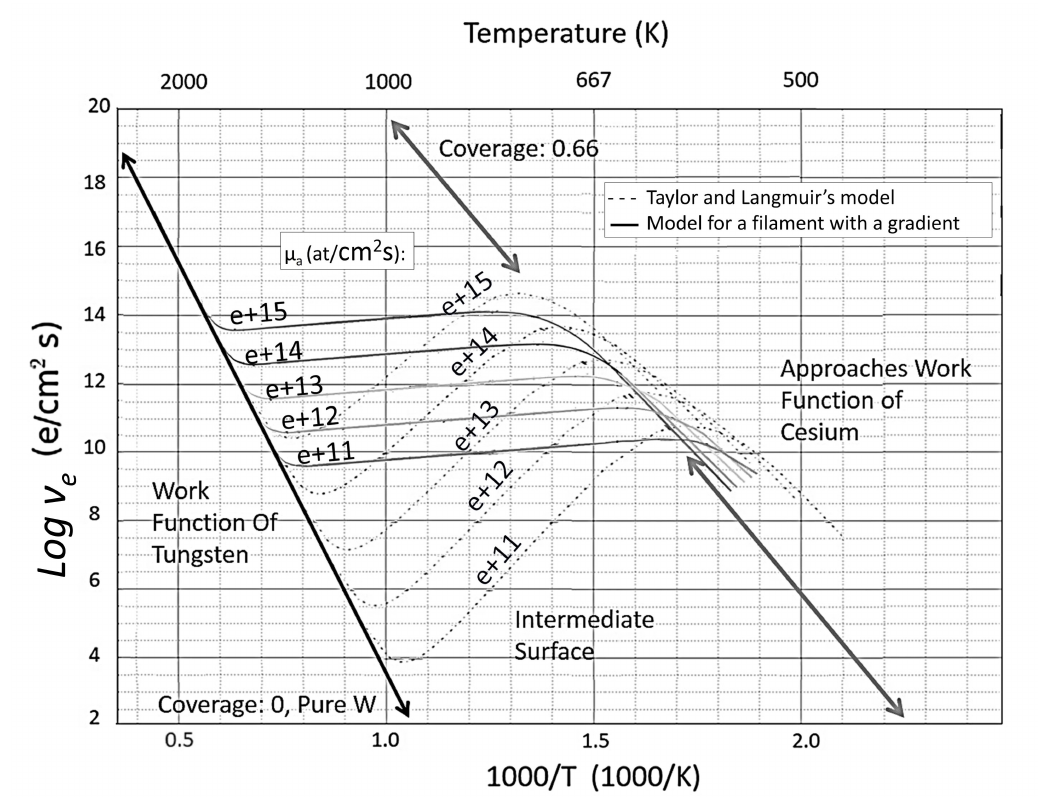
Figure 1. The electronic thermionic emission calculated with Taylor and Langmuir‘s measurements is shown as dotted lines for five values of cesium atom flux ( µ a ) ; each curve is labeled with the atomic flux, where e+11 ≡ 1 × 10 11 (at/cm 2 s). To account for the thermal gradient of the filament in our gauge, we have corrected the Taylor and Langmuir model by integrating over the filament, with the result shown as solid lines. The features of the curves such as the peaks and valleys become flattened with a filament that has a temperature gradient: The hotter central parts of the filament emit orders of magnitude fewer electrons than the colder edges of the filament, which obscures the emission of the center and flattens the valley of the curve. The y -axis indicating thermionic emission is in the log